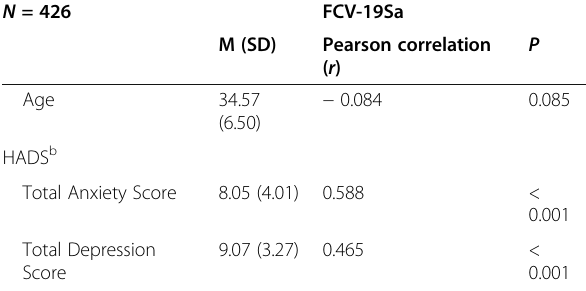
Table 2 Correlation between the score of FCV-19S and severity of anxiety and depressive symptoms among physicians N =